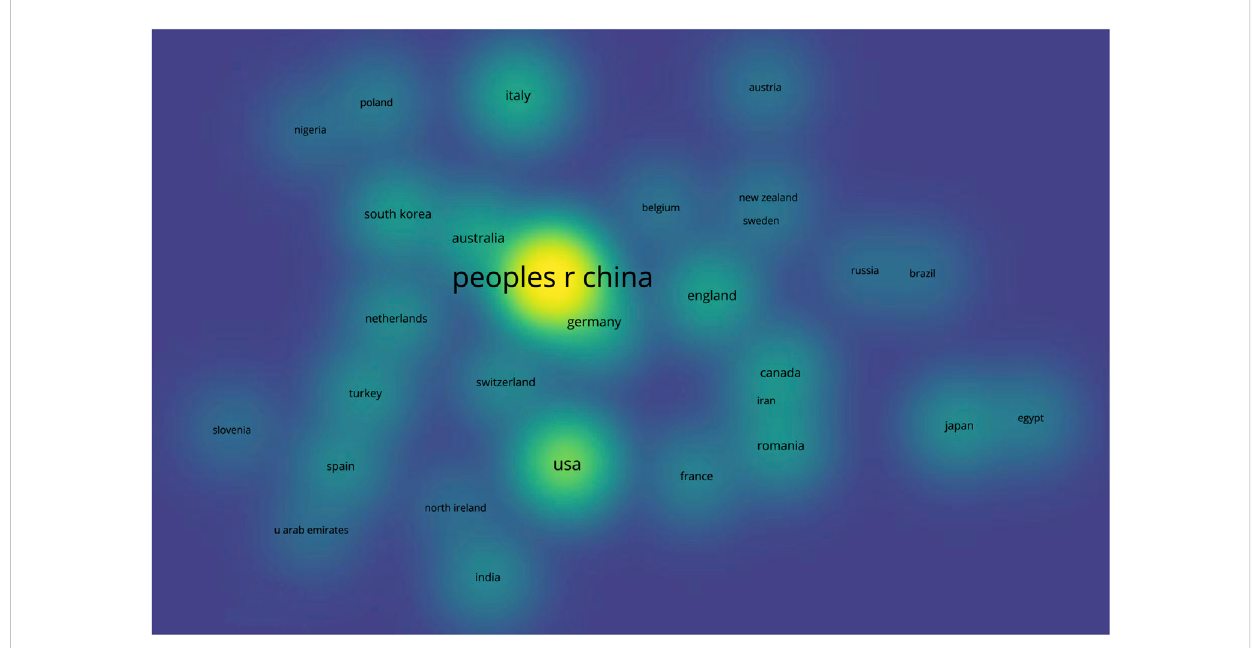
FIGURE 2 Densityvisualizationofthedistributionofallpublicationsacrosscountries.(Largerandbrighterbubblesindicatethegreatestnumberofpublications in the fi eld of additive manufacturing technology in pelvic surgery from a speci fi c country, while closer bubbles in space indicate closer national collaborations.).